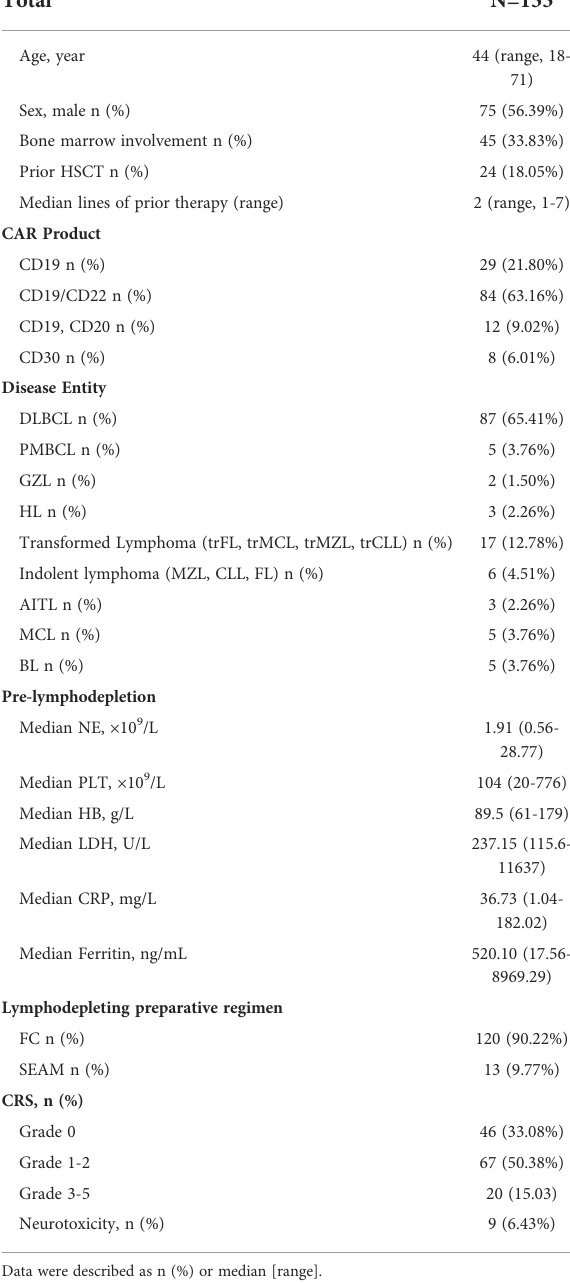
TABLE 1 Demographic and clinical characteristics of